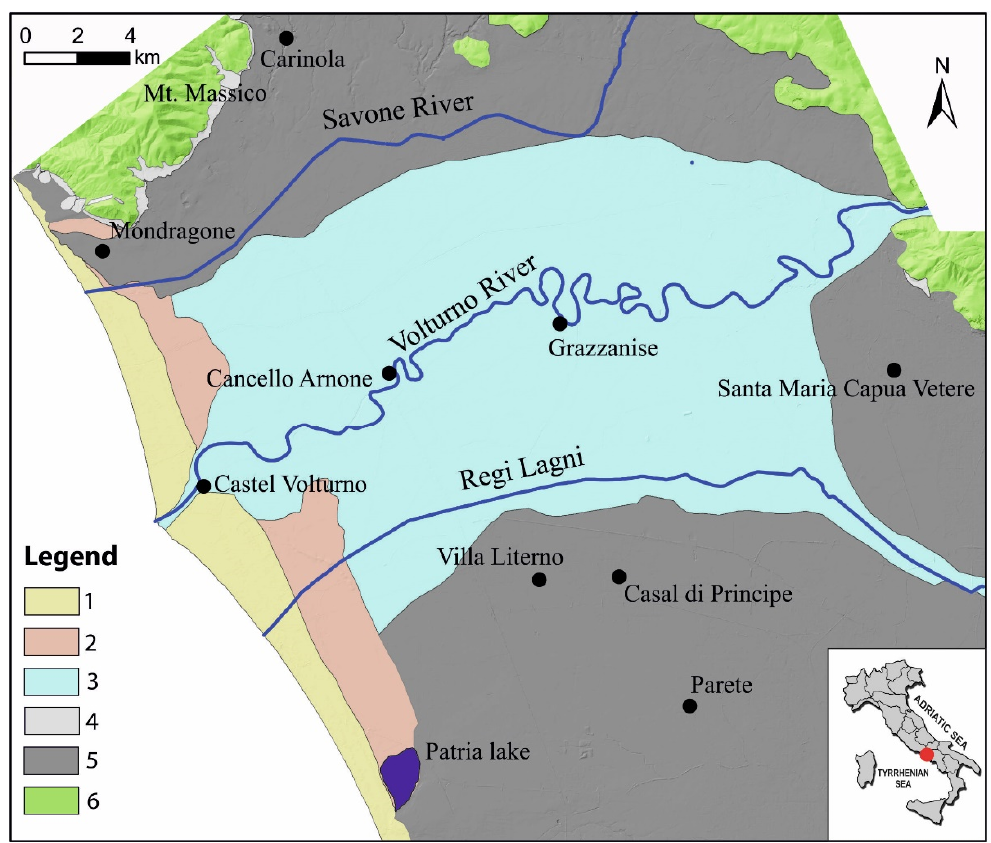
Figure 1. Simplified geological map of the Volturno Plain area; Legend: (1) dunal ridge deposits (Holocene); (2) marsh deposits (Holocene); (3) alluvial deposits (Late Pleistocene-Holocene); (4) slope waste deposits (Late Pleistocene-Holocene); (5) lavas and pyroclastic rocks of Roccamonfina Volcano, Phlegraean Fields, and Mt. Somma-Vesuvius (Middle Pleistocene-Holocene); (6) Pre-Quaternary bedrock.